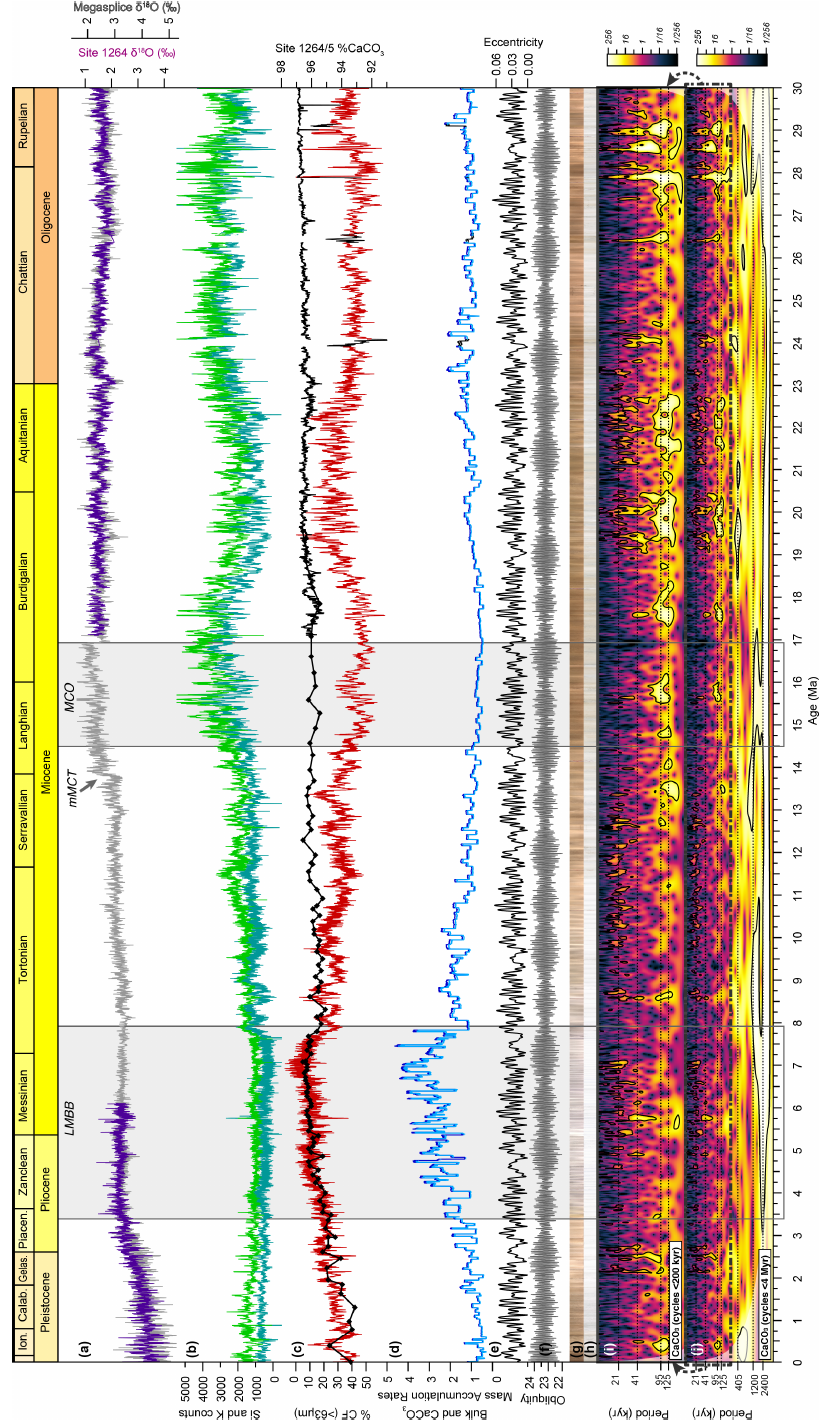
Figure 5. New data from Site 1264–1265 on the new astrochronology. (a) Site 1264 benthic foraminiferal δ 18 O (Bell et al., 2014; Liebrand et al., 2016; Westerhold et al., 2020) and the benthic δ 18 O Megasplice (De Vleeschouwer et al., 2017). (b) Site 1264 Si intensity (counts). The left axis of (c) shows % > 63µm coarse fraction (%CF) (Liebrand et al., 2016; Keating-Bitonti and Peters, 2019), and the right axis shows XRF-derived CaCO 3 data from Sites 1264 (dark red) and 1265 (black). (d) Bulk and CaCO 3 MARs for Sites 1264 (dark and light blue, respectively) and 1265 (black and grey, respectively). (e) Eccentricity and (f) obliquity solutions (Laskar et al., 2004). (g) Line scan and (h) core box photo Site 1264–1265 composite core photos. (i) Wavelet spectra in the time domain of the CaCO 3 data detrended to remove cycles over 200kyr. (j) Wavelet spectra in the time domain of the CaCO 3 data detrended to remove cycles over 4Myr (Torrence and Compo, 1998; Grinsted et al., 2004). The MCO, mMCT and LMBB are annotated. Clim. Past, 17, 2091–2117,